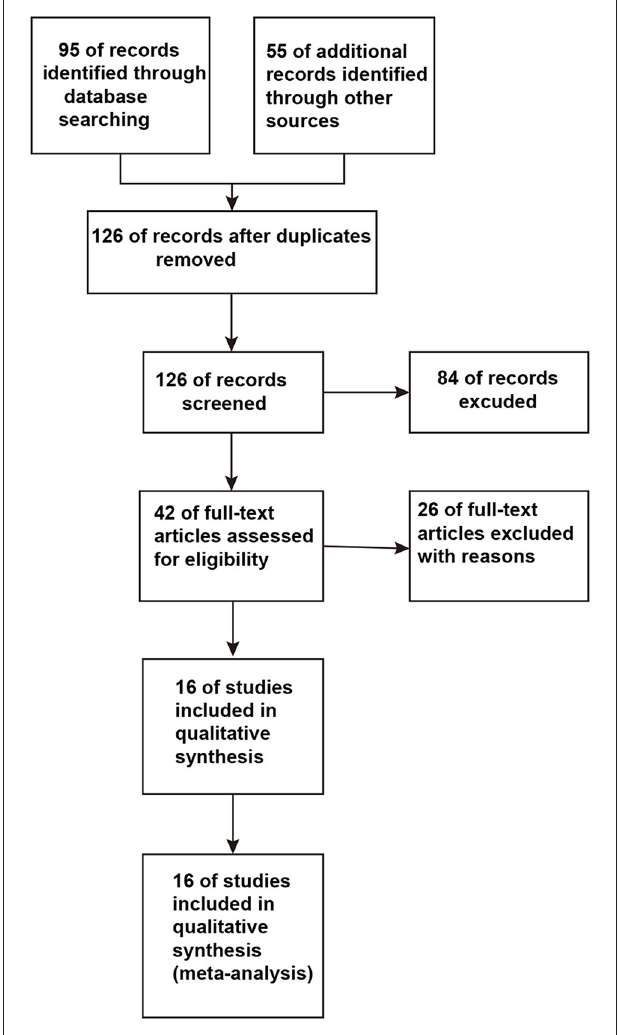
FIGURE 1 | Flowchart of the study selection